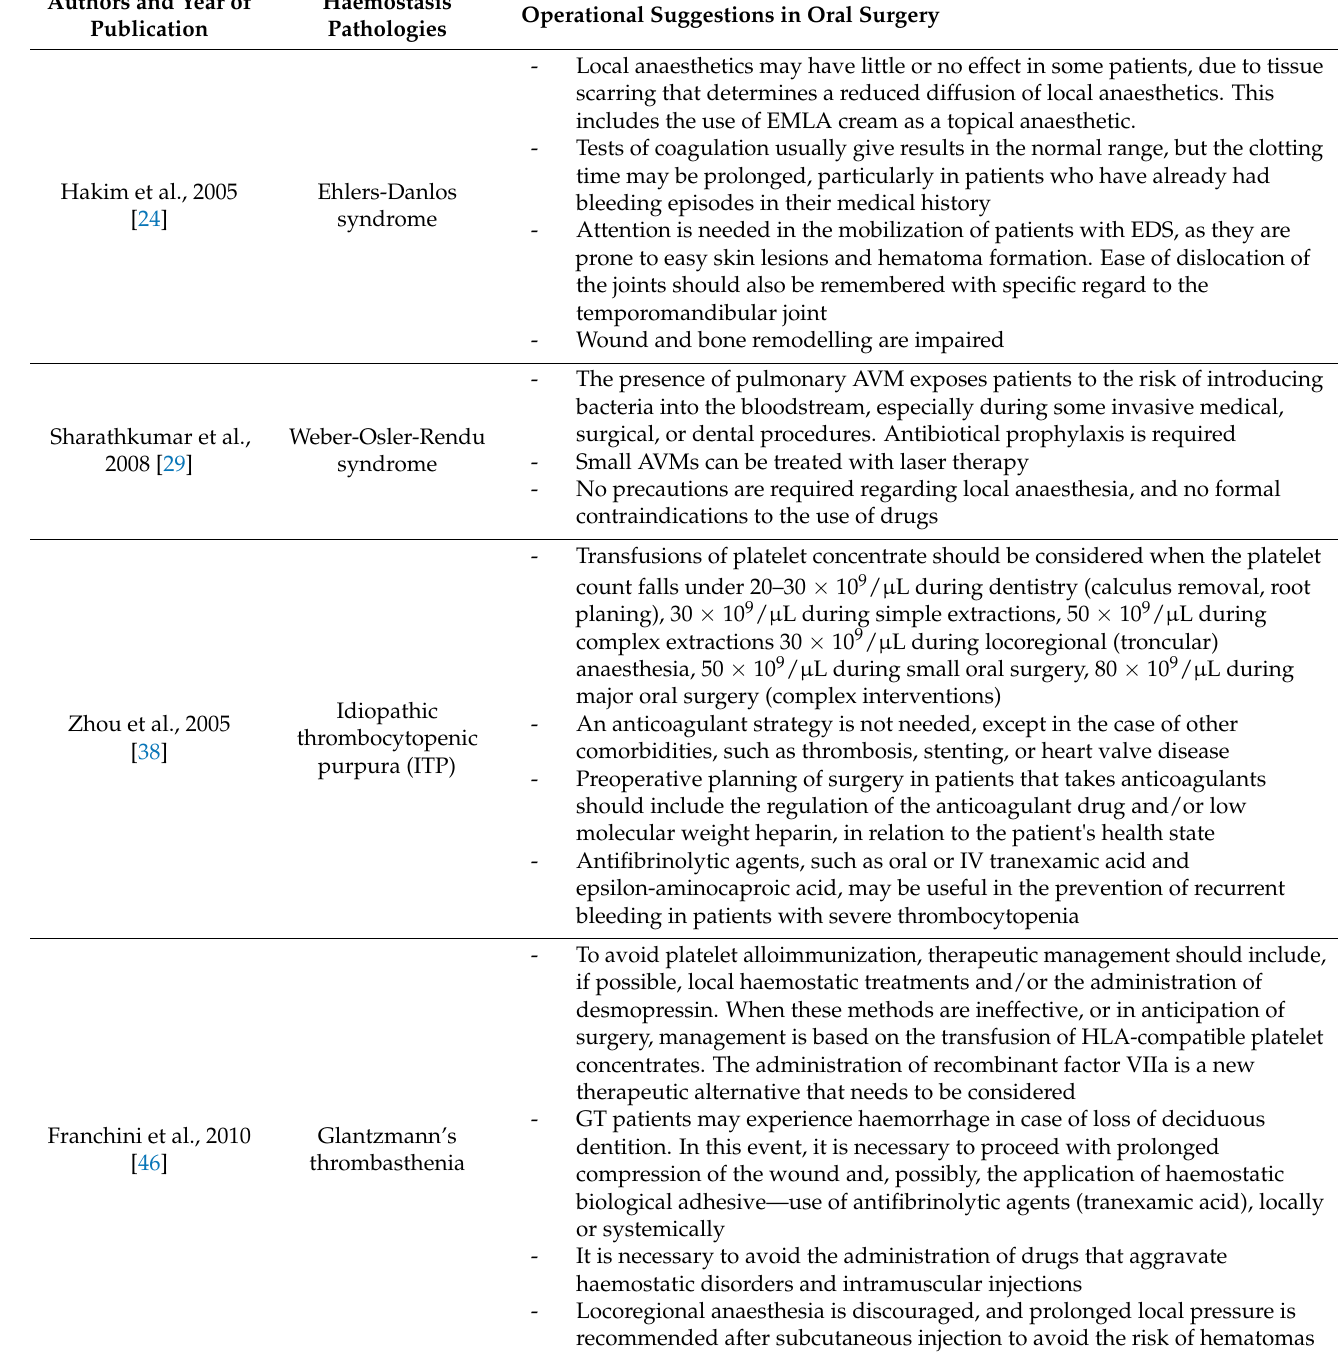
Table 2. Operational suggestions for hemostasis pathologies in oral